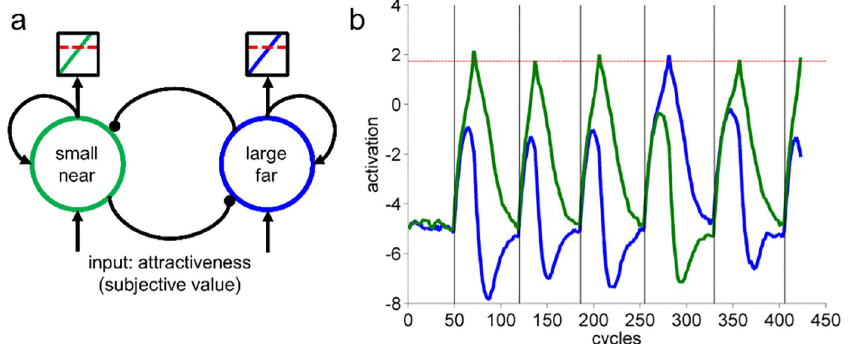
Fig 1. The neural attractor model. a) Sketch of the neural-inspired attractor model. Each units’ activation represents the attractiveness of one option and inhibits the activation of the alternative option. When an option’s activation reaches the choice-threshold, the choice of this option is elicited. b) Activation flow across six consecutive choices. After choosing the (here more attractive) small-near option in the first trial, the system perseverates with this choice and only occasional switches to the alternative can be observed, which are caused by noise in the